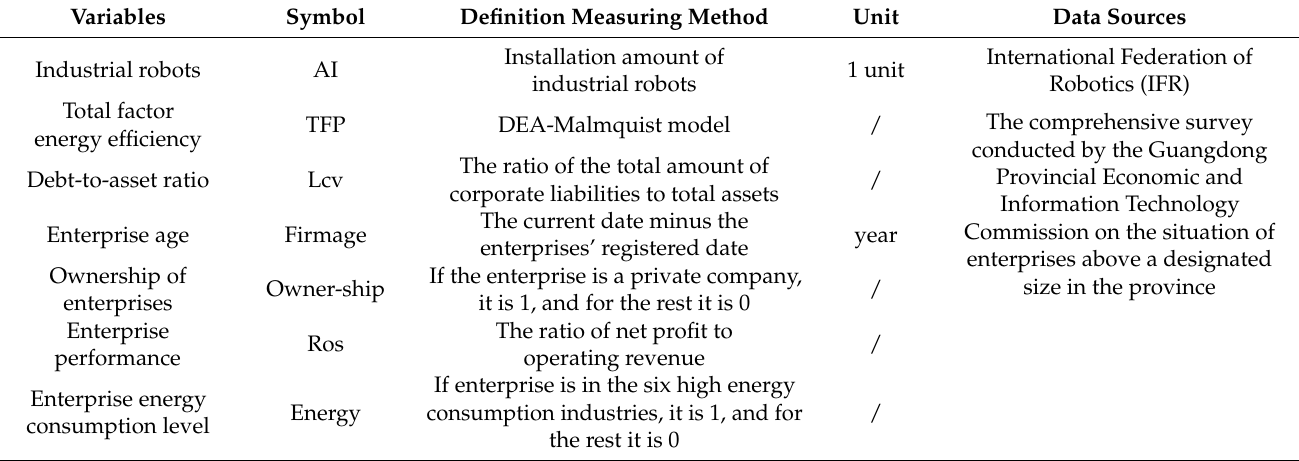
Table 1. Description of variables.